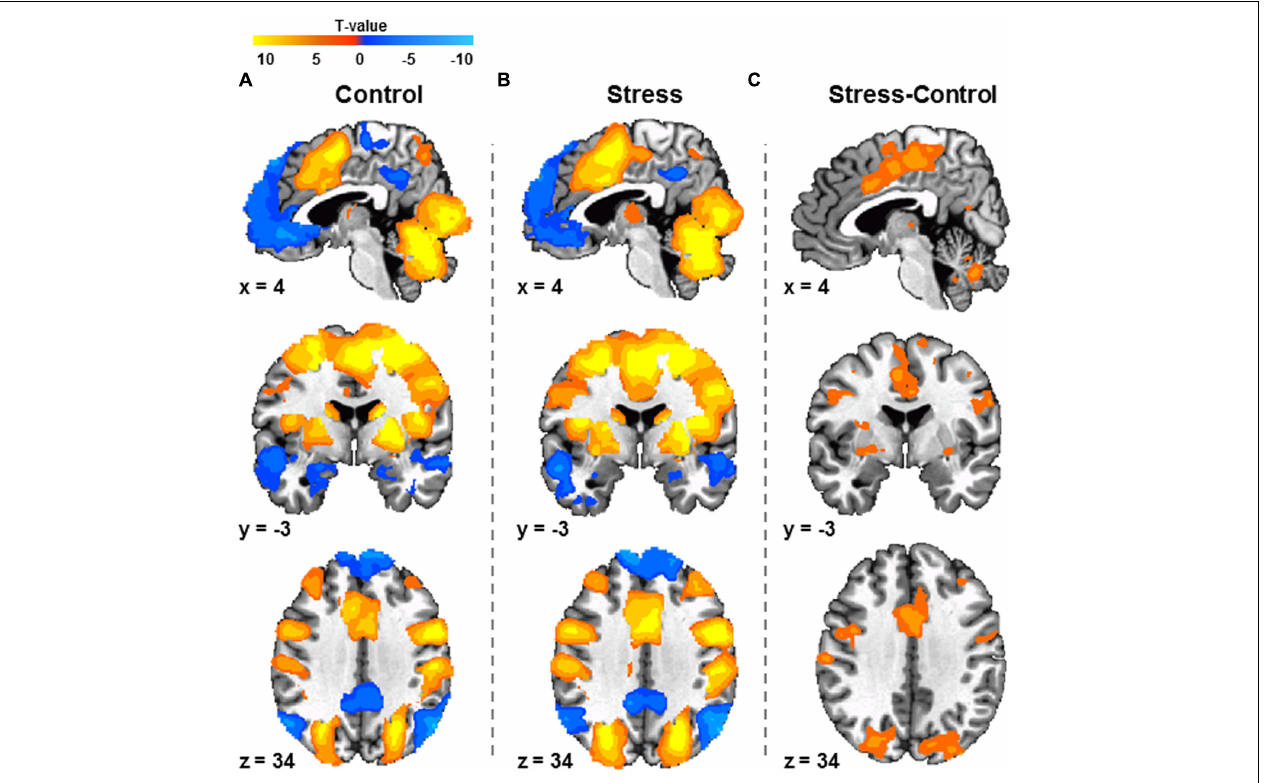
FIGURE 3 | Response to Control MIST (A) , Stress MIST (B) , and the differential (Stress vs. Control) response during the MIST (C) ( N = 53). Differences were observed between Stress and Control conditions within regions including the dorsomedial prefrontal cortex, dorsolateral prefrontal cortex, and inferior parietal lobule. Images are FWE corrected p < 0.05 and presented in radiologic